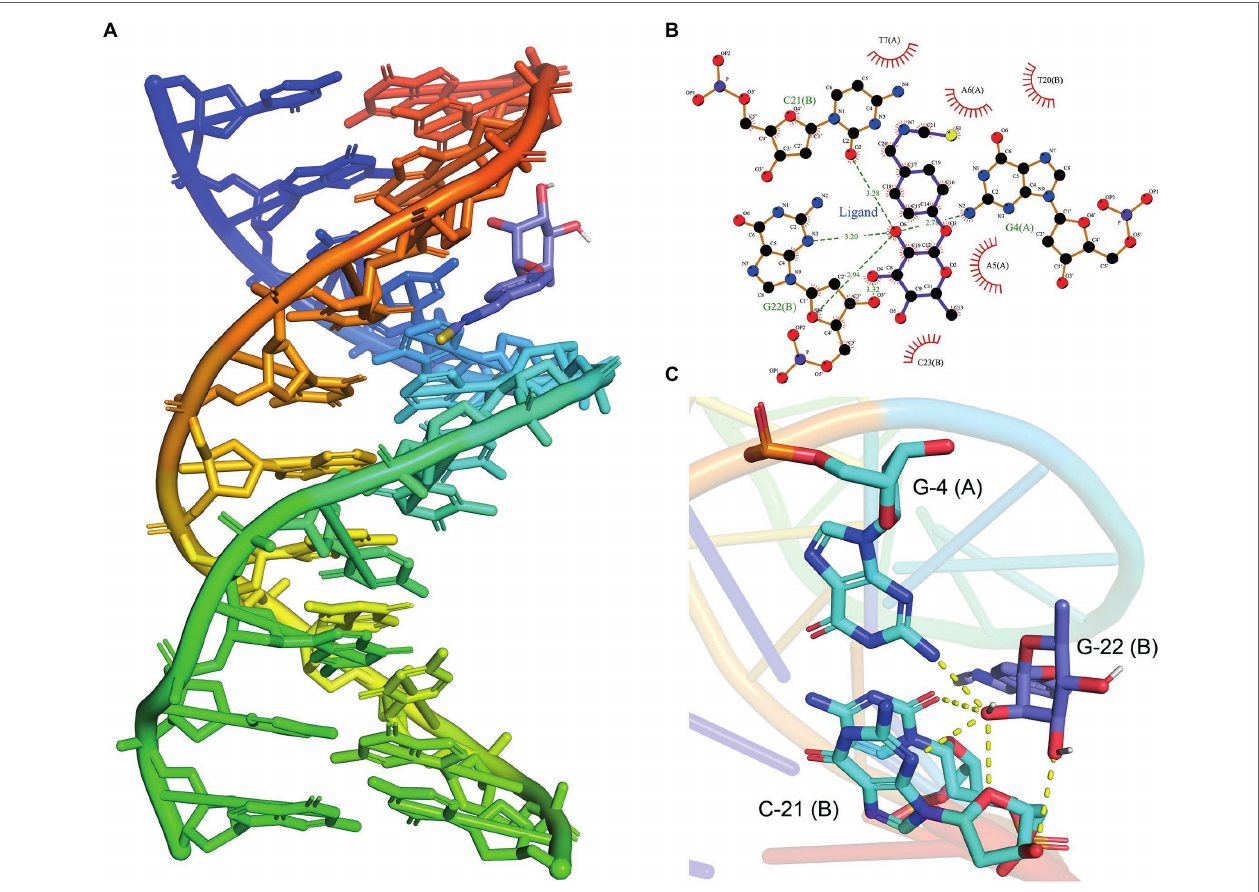
FIGURE 7 | Effects of moringin on DNA of Listeria monocytogenes by molecular docking. (A) Binding poses between moringin and DNA. (B) The 2D plot of the interactions between moringin and DNA. (C) The 3D plot of the interactions, with different base names marked. The letters in parentheses represented different strands of